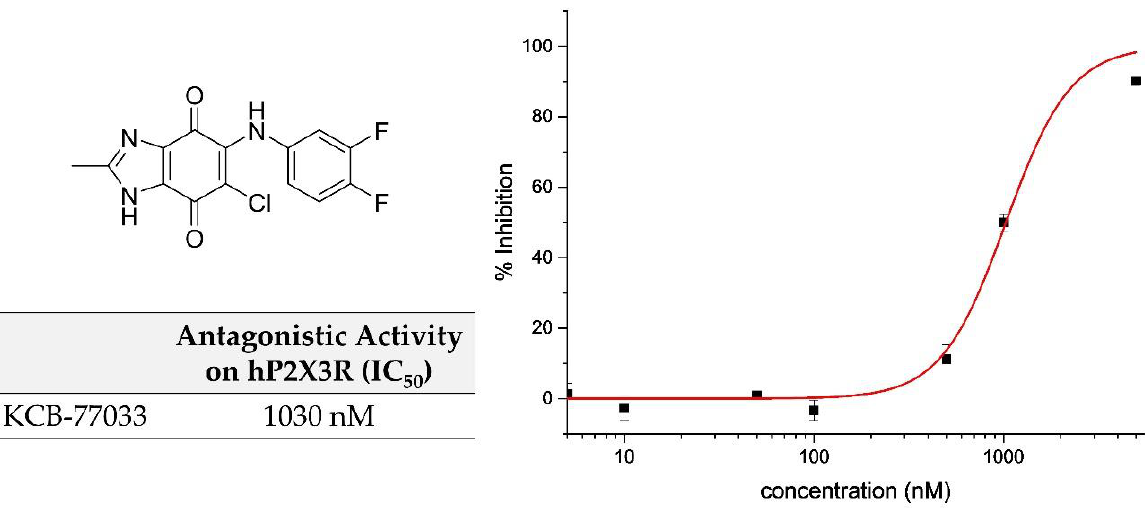
Figure 2. The hit compound identified from the library screening of 8364 compounds.